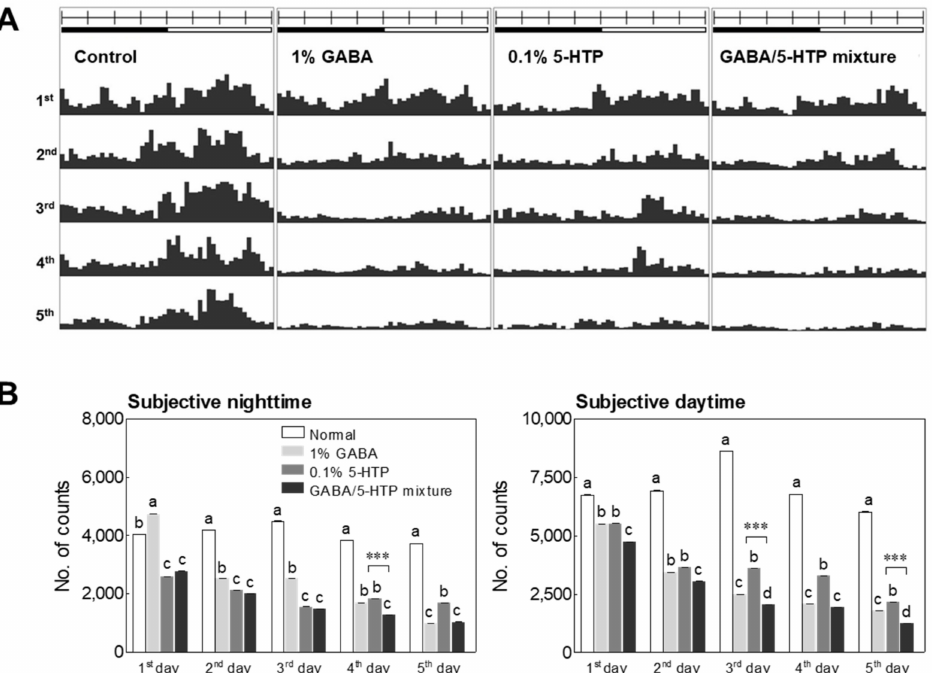
Figure 1. Effects of the two amino acids and the GABA/5-HTP mixture on the locomotor activity of Drosophila flies. ( A ) Typical actograms of the control group ( n = 100) and flies exposed to GABA ( n = 100), 5-HTP ( n = 100), and the GABA/5-HTP mixture ( n = 100). The graphic representation of locomotor activities was generated by the Actogram J program using average activity in a 30 min interval calculated over 5 days. ( B ) Locomotor activities during subjective nighttime and daytime. Data are presented as means ± standard error of the mean for each group. Bars marked with different letters indicate significant ( p < 0.05) differences between the time points from each other by Tukey’s test. Symbols indicate significant differences at *** p < 0.001 by two-way ANOVA analysis.